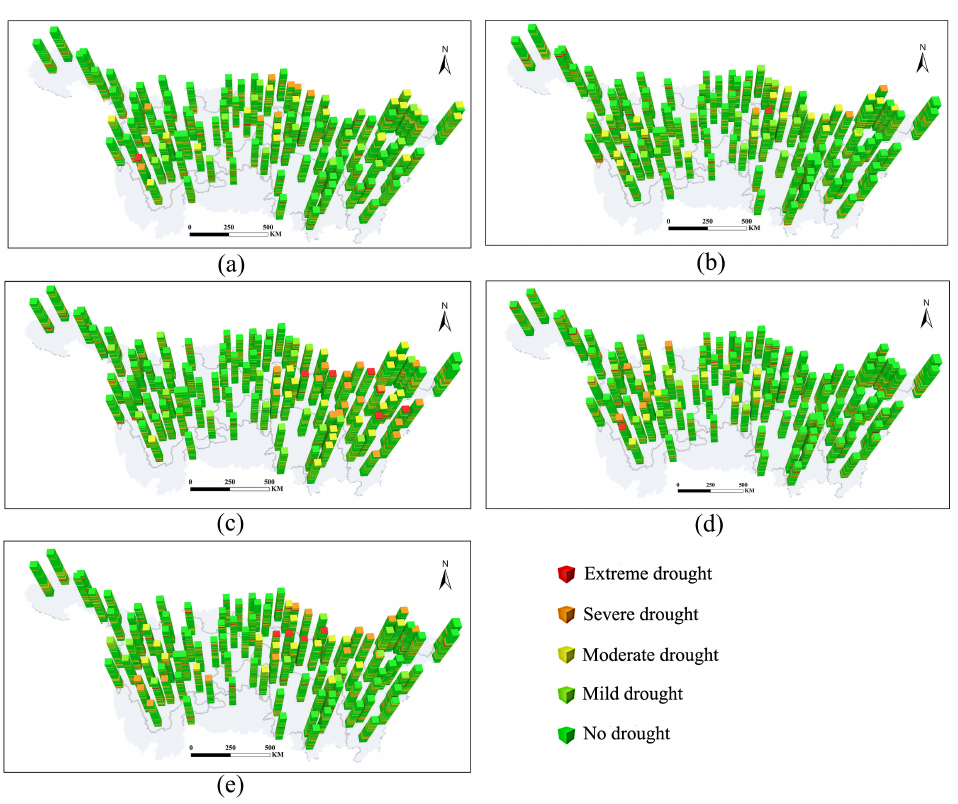
Figure 9. Space-time cube results of multi-scale SPEI in Yangtze River Basin. ( a ) Spring; ( b ) summer; ( c ) autumn; and ( d ) winter; ( e )